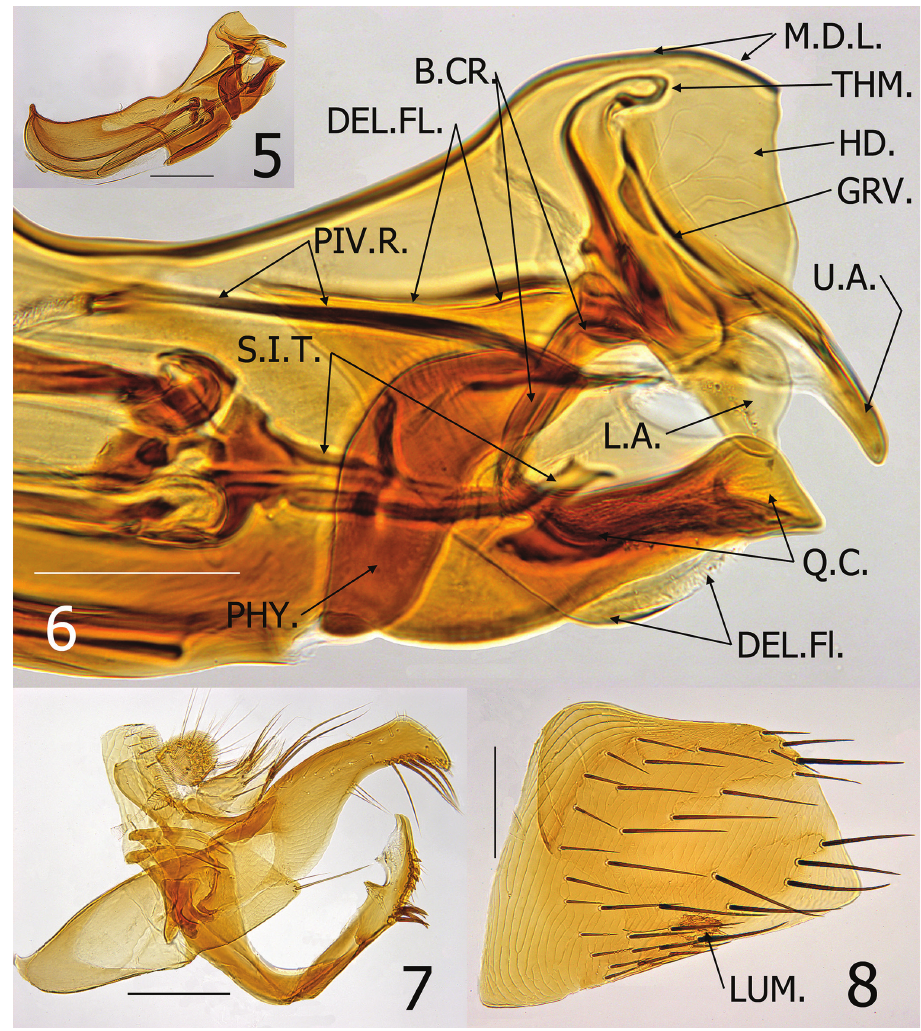
apex of aedeagus (B.CR. = body of crochet, DEL.FL = deltoid flap of hood of aedeagus, GRV. = groove- like structure of Ford’s sclerite, HD. = hood of aedeagus, L.A. = lower arm of securifer, M.D.L. = median dorsal lobe of aedeagus, PHY. = phylax, PIV.R. = pivotal ridge of phylax, Q.C. = quasi-crochet, S.I.T. = sclerotized inner tube, THM. = thumb-like apex of alpha-portion of Ford’s sclerite, U.A. = upper arm of securifer 7 Basimere, telomere, and S-IX 8 Eighth sternum, LUM. = lumacaudate process. (Scale: 5, 7–8 = 200 µm; 6 = 100